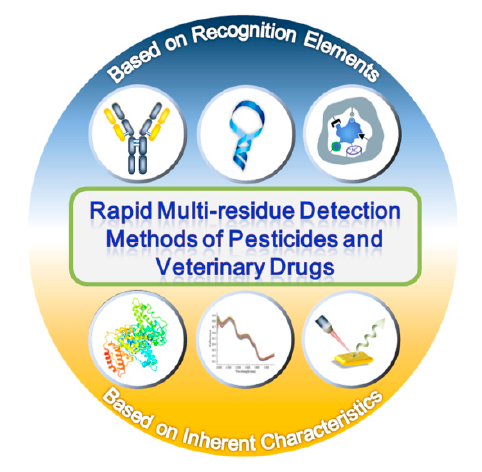
Figure 1. Rapid multi-residue detection methods of pesticides and veterinary drugs.